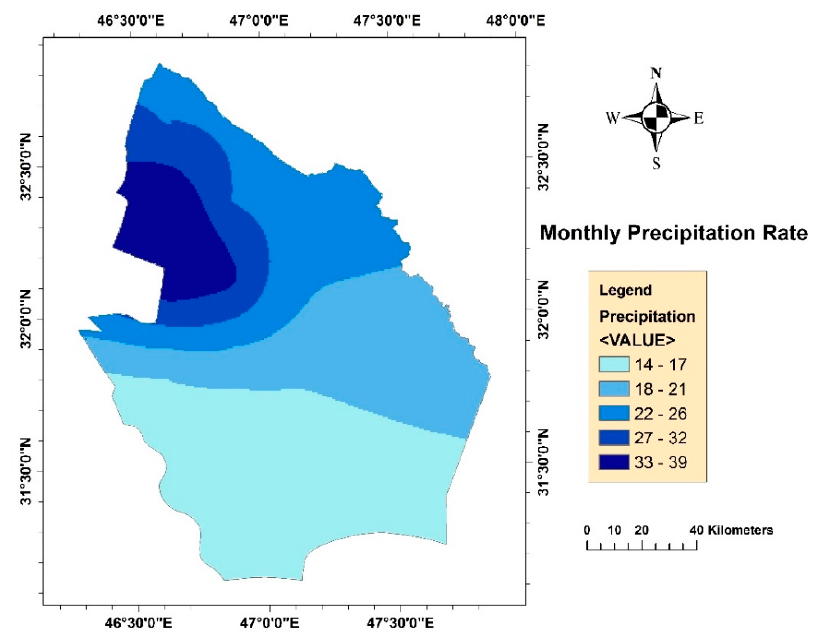
Figure 5. Interpolated map for the monthly precipitation rate based on Tropical Rainfall Measuring Mission (TRMM) data (mm/month).